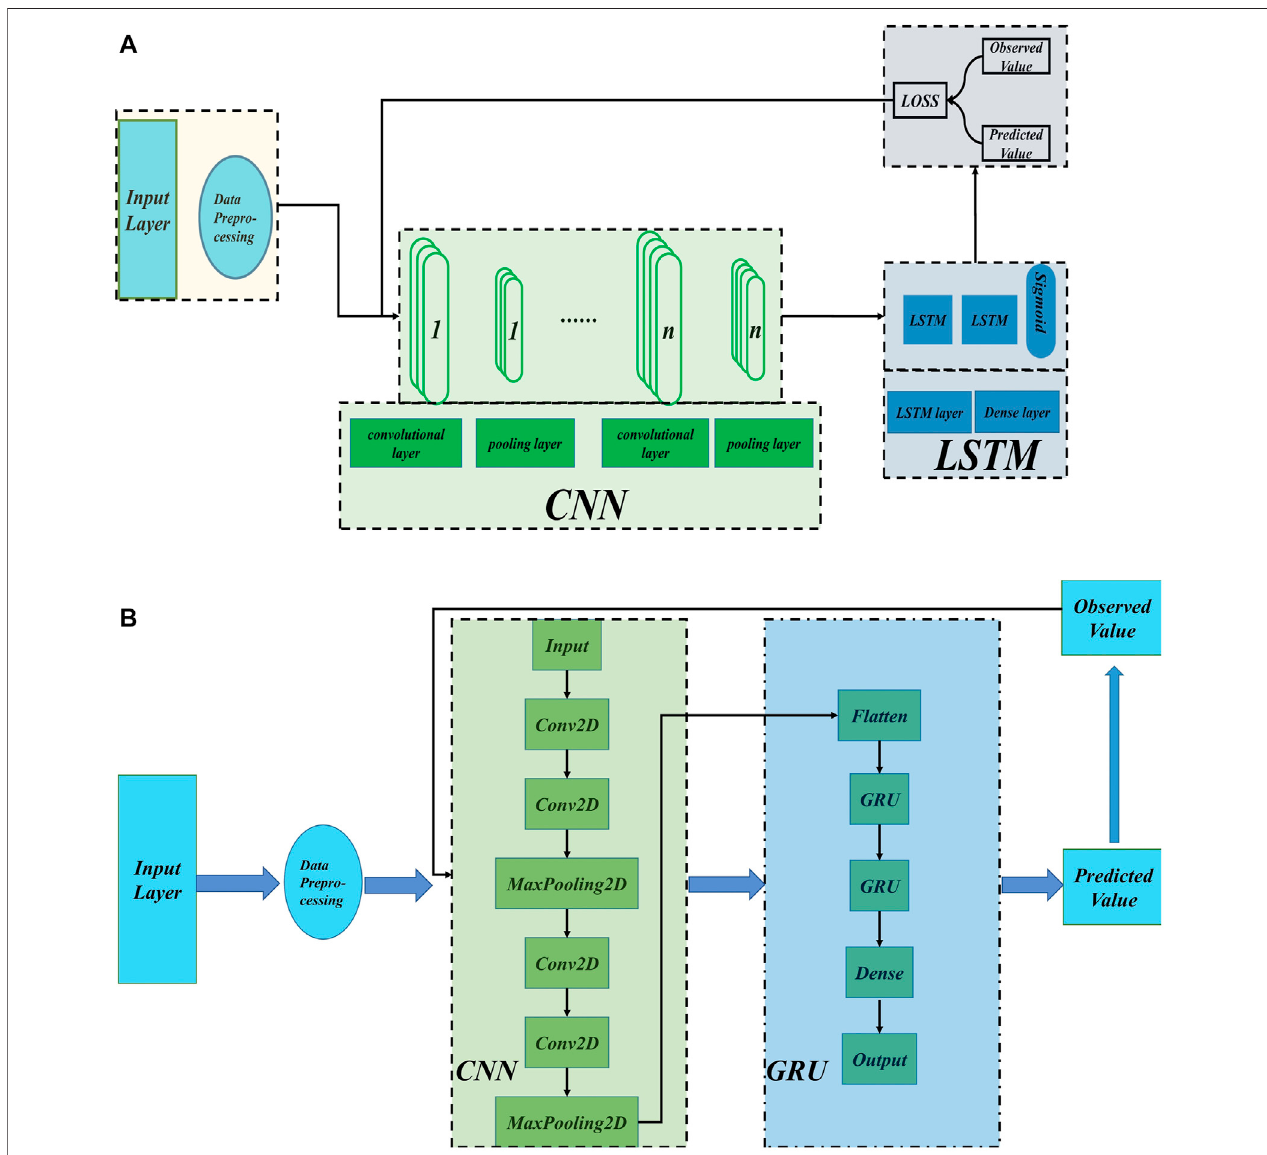
FIGURE 1 | Flowchart of the proposed deep learning models (A) CNN – LSTM and (B) CNN – GRU.